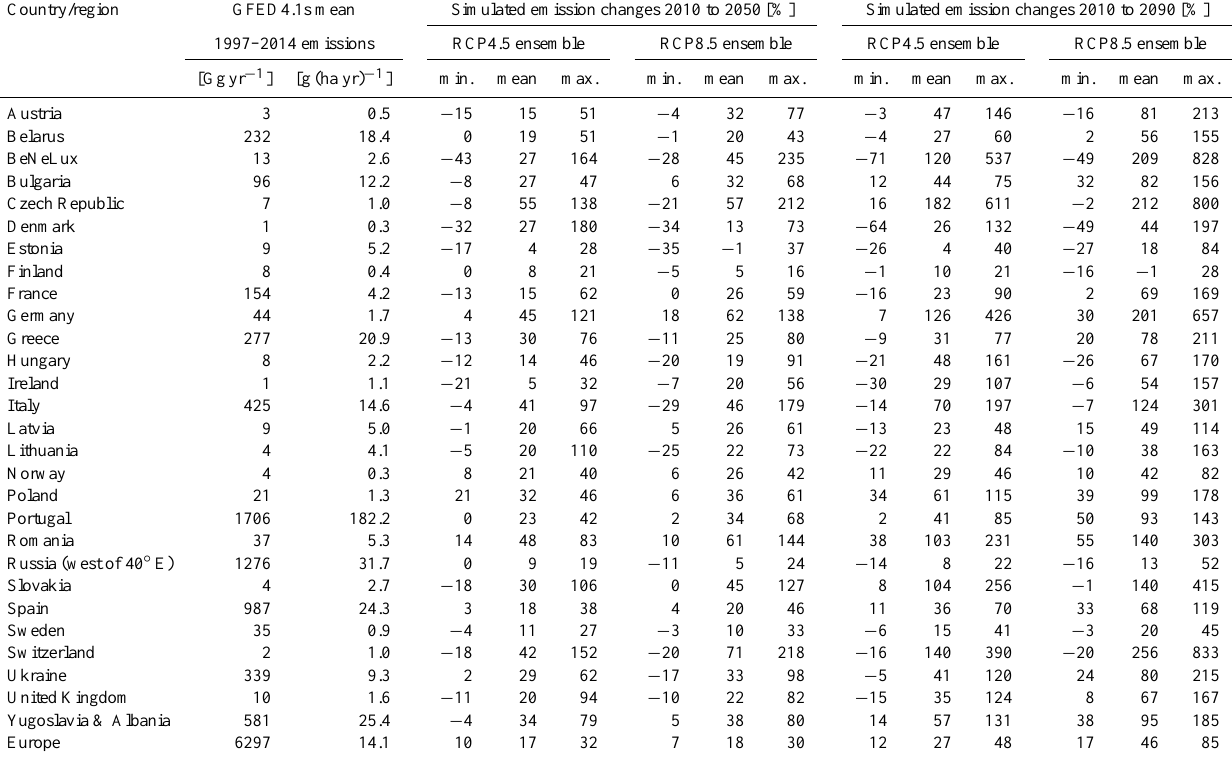
Table 3. Changes in simulated PM 2 . 5 emissions for regions used in the